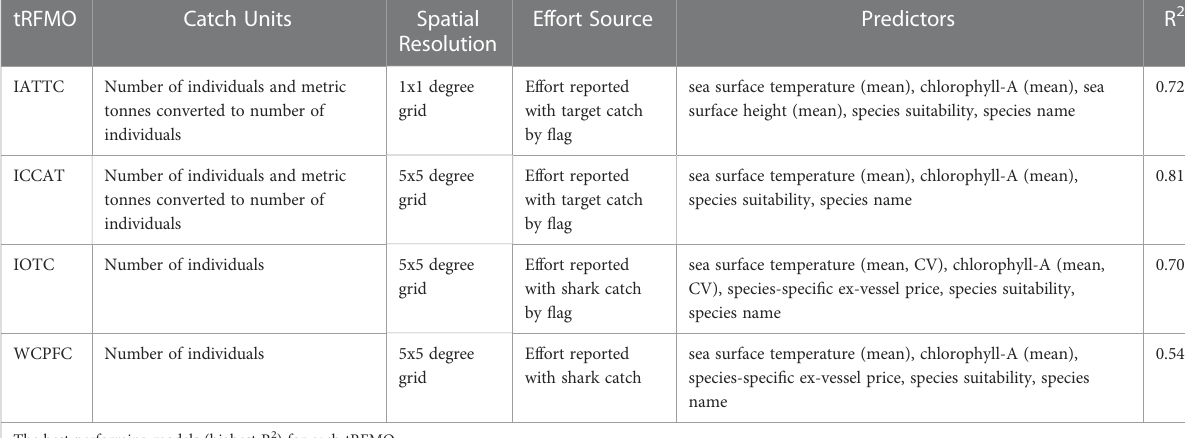
TABLE 3 Random Forest model performance.